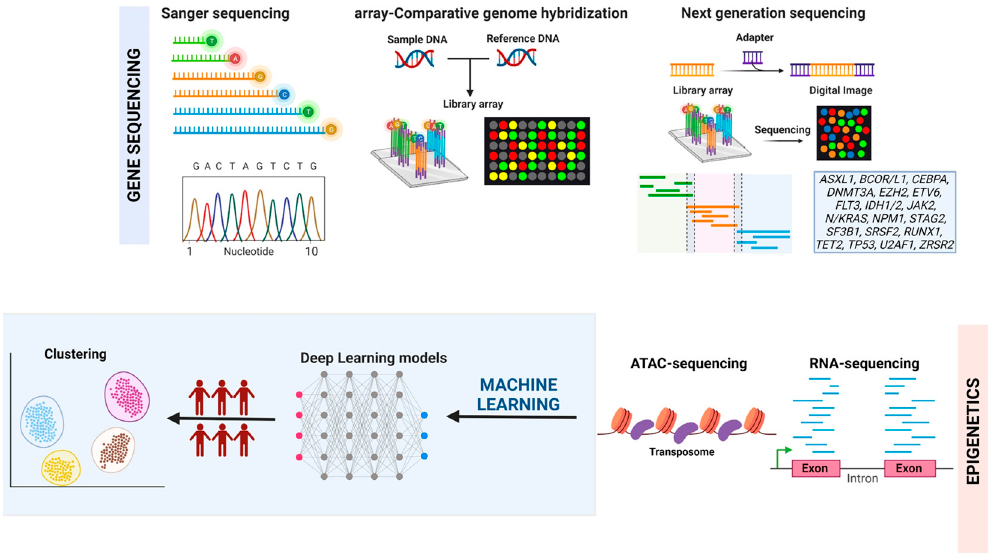
Figure 1. Integration of genomic and transcriptomic features using machine learning. Schematic representation of the possible combination of results derived from techniques used to study gene variations and RNA profiles including chromatin analysis. The figure was created using BioRender.com.